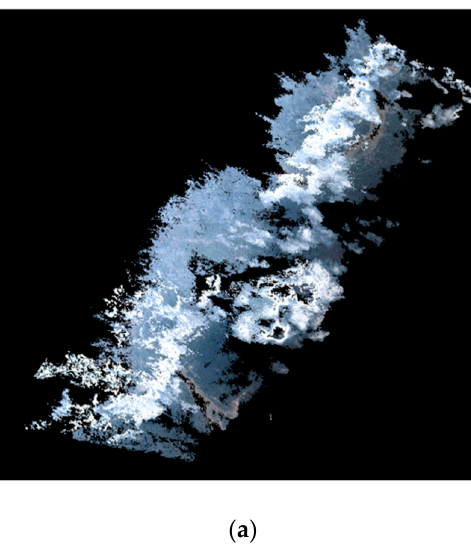
Figure 5. ( a ) Point cloud data, and ( b ) an orthomosaic image of the study area.